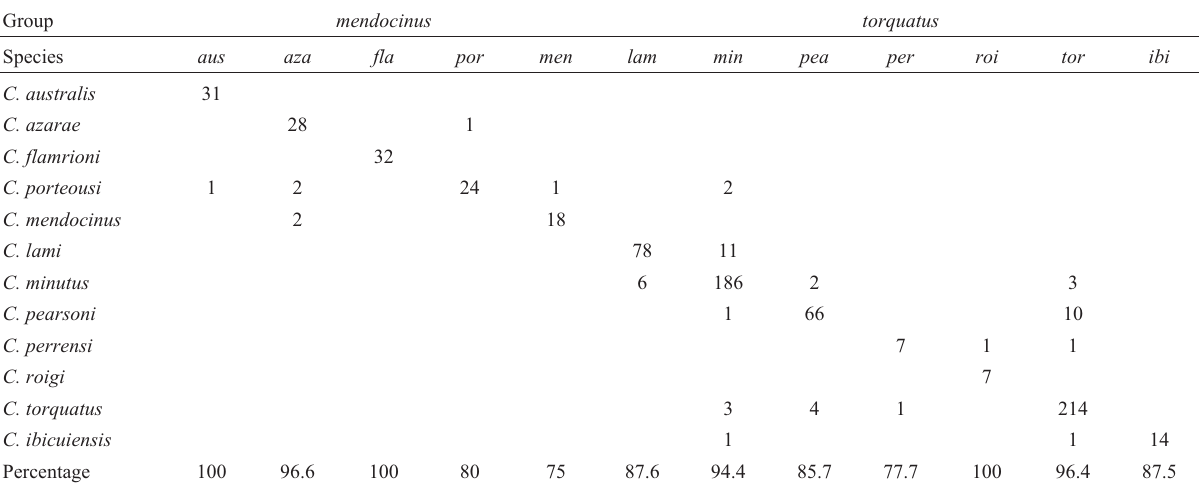
Table 3 - Classification of 12 species of Ctenomys from mendocinus and torquatus groups for dorsal view of the skull using linear discriminant analysis (LDA).Thediagonallineshowsthesamplesthatwerecorrectlyclassified.Thepercentageofcorrectclassificationisgiveninthelastline.Thespeciesab- breviations follow the same order in the first column and Table